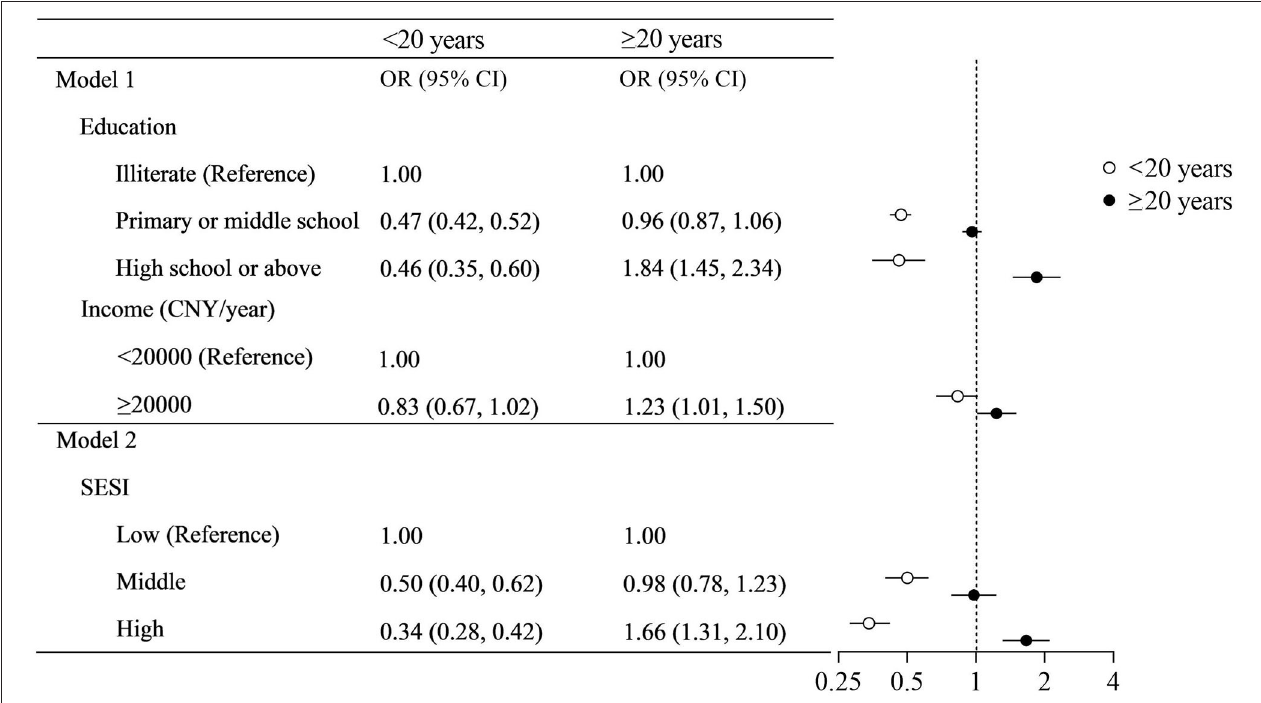
FIGURE 3 | Association of socioeconomic status with overweight/obesity by age at arrival. Models adjusted for age, gender, smoking, drinking, occupational physical activity, leisure-time exercise, and length of